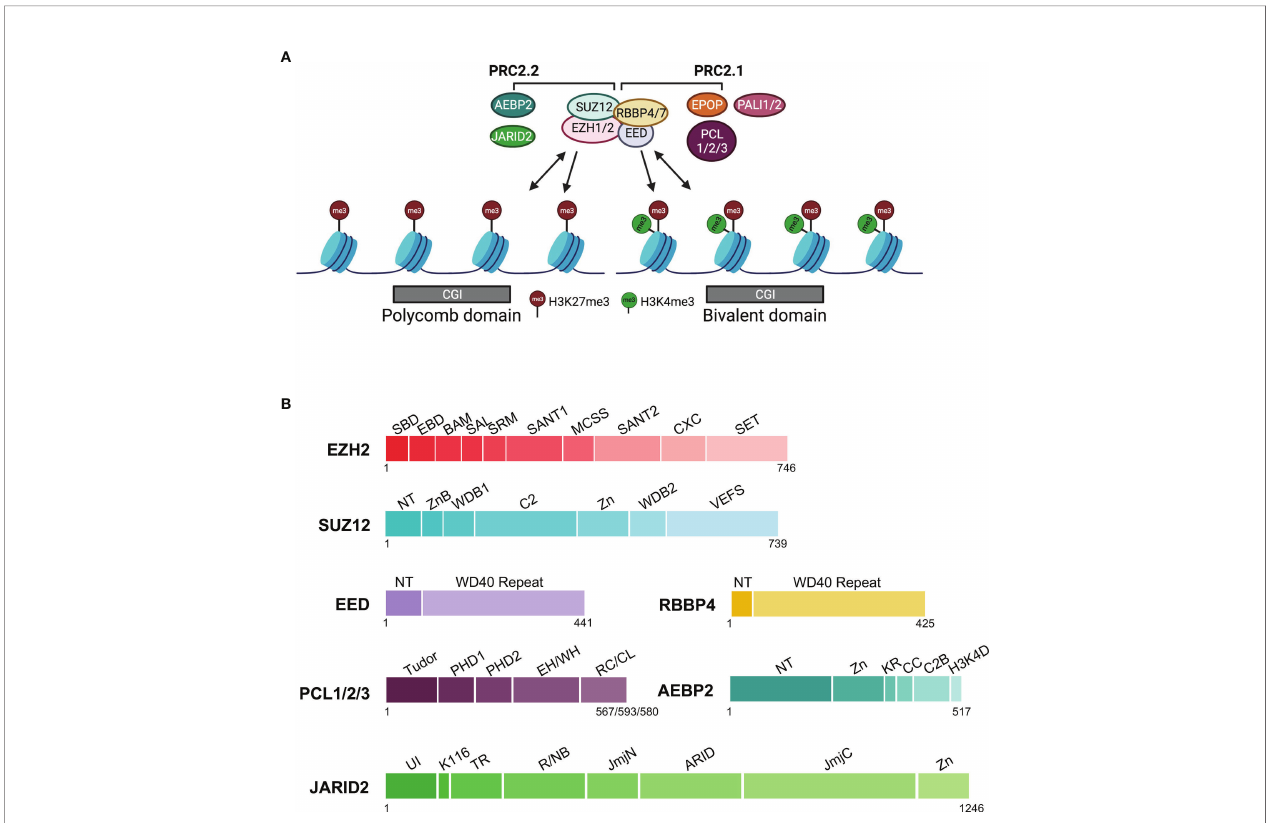
FIGURE 1 | Complex composition, chromatin association, and protein domain structure of PRC2.1 and PRC2.2. The core subunits and accessory subunits speci fi c to PRC2.1 and PRC2.2 are indicated. (A) Complex composition and chromatin association. Single-headed arrows depict the deposition of histone marks, and double-headed arrows indicate chromatin binding. CGI chromatin in the Polycomb domain or bivalent domain is represented by gray rectangles. (B) Domain structure of PRC2 subunits. EPOP and PALI1/PALI2 of PRC2.1 are not shown, as their 3D structures have not yet been determined. Linker regions are omitted. EZH2: SBD (SANT1-Binding Domain), EBD (EED-Binding Domain), BAM ( b -Addition Motif), SAL (SET Activation Loop), SRM (Stimulation-Responsive Motif), SANT1 (SWI3, ADA2, N-COR, and TFIIIB 1), MCSS (Motif Connecting SANT1 and SANT2), SANT2 (SWI3, ADA2, N-COR, and TFIIIB 2), CXC, SET (SU(VAR)3-9, Enhancer- of-zeste and Trithorax); SUZ12: NT (N-Terminal), ZnB (Zinc Finger-Binding), WDB1 (WD40-Binding 1), C2, Zn (Zinc fi nger), WDB2 (WD40-Binding 2), VEFS (VRN2, EMF2, FIS2, and SU(Z)12); EED: NT (N-Terminal), WD40; RBBP4: NT (N-terminal), WD40; PCL1/2/3 or PHF1/MTF2/PHF19: Tudor, PHD1 (Plant HomeoDomain 1), PHD2 (Plant HomeoDomain 2), EH/WH (Extended Homology/Winged-Helix), RC/CL (Reversed Chromo/Chromo-Like); AEBP2: NT (N-terminal), Zn (Zn fi nger), KR (K (lysine) and R (arginine)-rich), CC (Central Connecting), C2B (C2-Binding), H3K4D (H3K4 Displacement); JARID2: UI (Ubiquitin Interaction), K116 (K (lysine) 116), TR (TransRepression), R/NB (RNA/Nucleosome Binding, JmjN (Jumonji N), ARID (AT-Rich Interaction Domain), JmjC (Jumonji C), Zn (Zinc fi